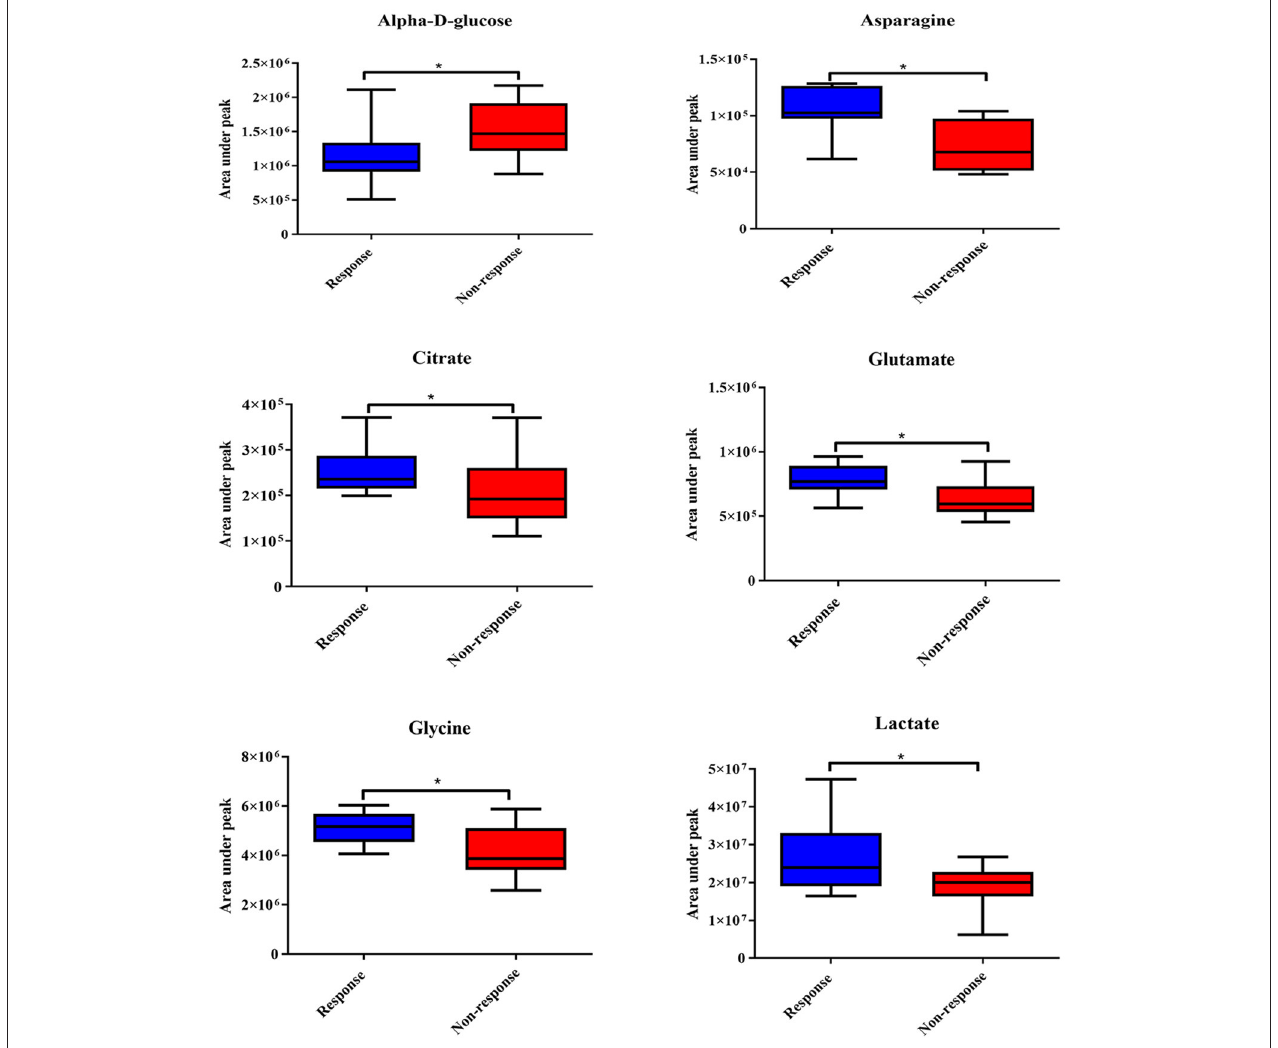
FIGURE 3 | Significantly changed metabolites in cisplatin response patterns from tumor tissues of patients with CCA. The blue color shows response group and red color shows non-response group. * indicates statistically